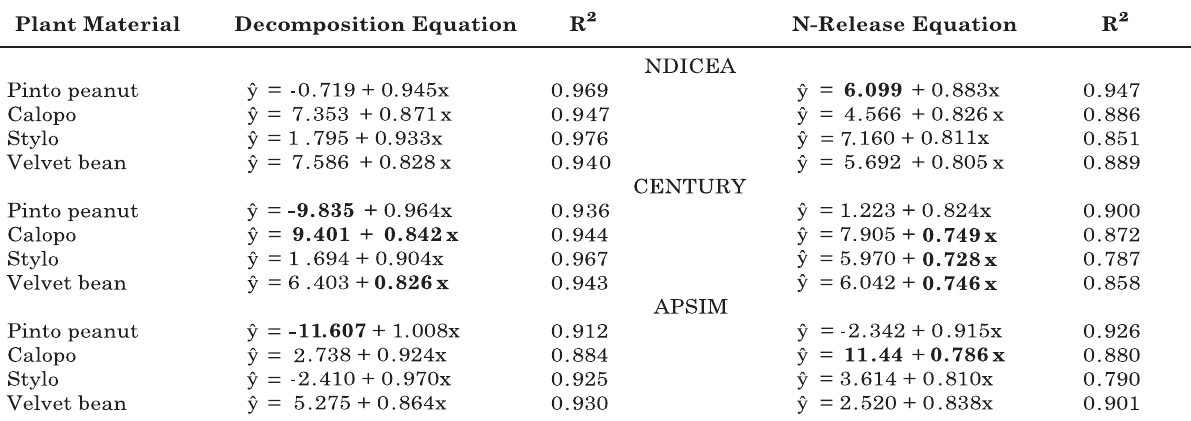
Figure 2. Dry matter and remaining N as a function of time (360 days) observed for residue of velvet bean (A and C) and calopo (B and D, respectively) and simulated by NDICEA, CENTURY and APSIM after calibration. The bars at the measurement points correspond to the confidence interval (5 %) for the observed average. The percentage is the average deviation, calculated using Equation 24. Table 5. Linear regression equation for decomposition and N-release rates observed ( w) in plant residues as a function of the data simulated (x) by NDICEA, CENTURY and APSIM, in 360 days of decomposition (municipality of Pedra